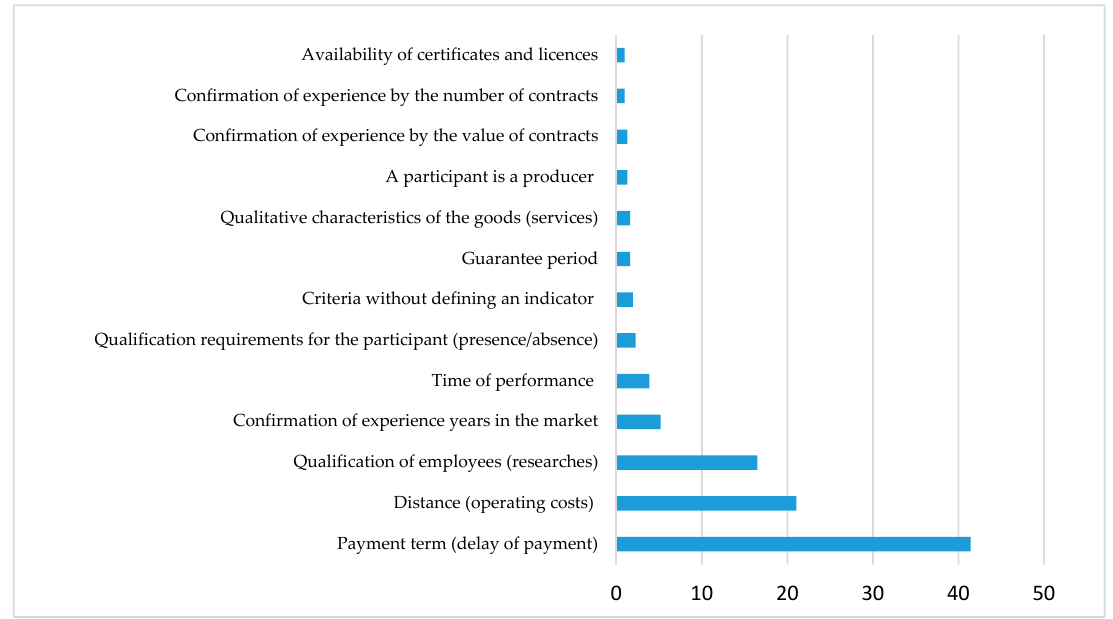
Figure 1. Structure of non-price criteria specified by the customer in the procurement of goods announcement in 2019. Source: compiled by the authors according to the data of the analytics module (Bi.prozorro 2019).